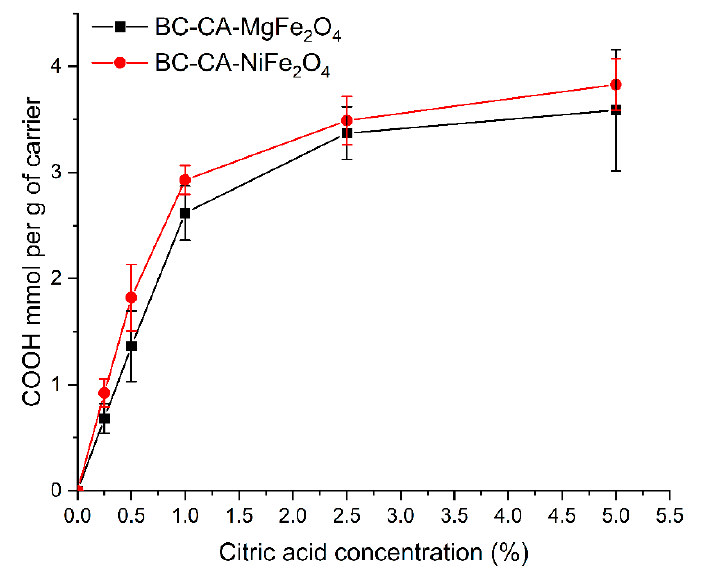
Figure 2. Influence of initial concentration of citric acid on the content of COOH in the structure of bacterial cellulose-based magnetic composites.